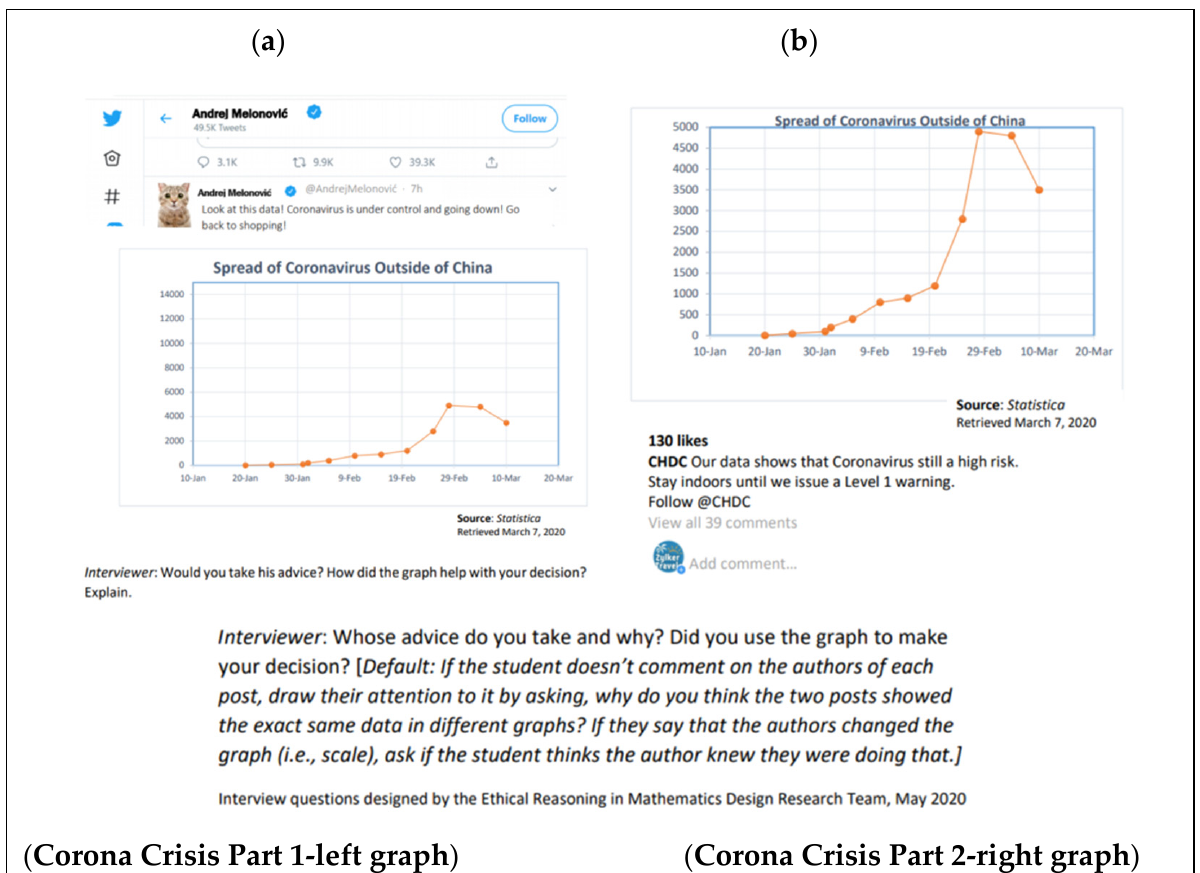
Figure 2. ( a ) Corona Crisis Part 1 depicts a Tweet from the president of a fictitious bank, using the data to suggest that infections were declining; ( b ) Corona Crisis Part 2 depicts a post from the fictitious Center for Health and Disease Control (CHDC) using the same dataset to claim that the disease presents a high risk.